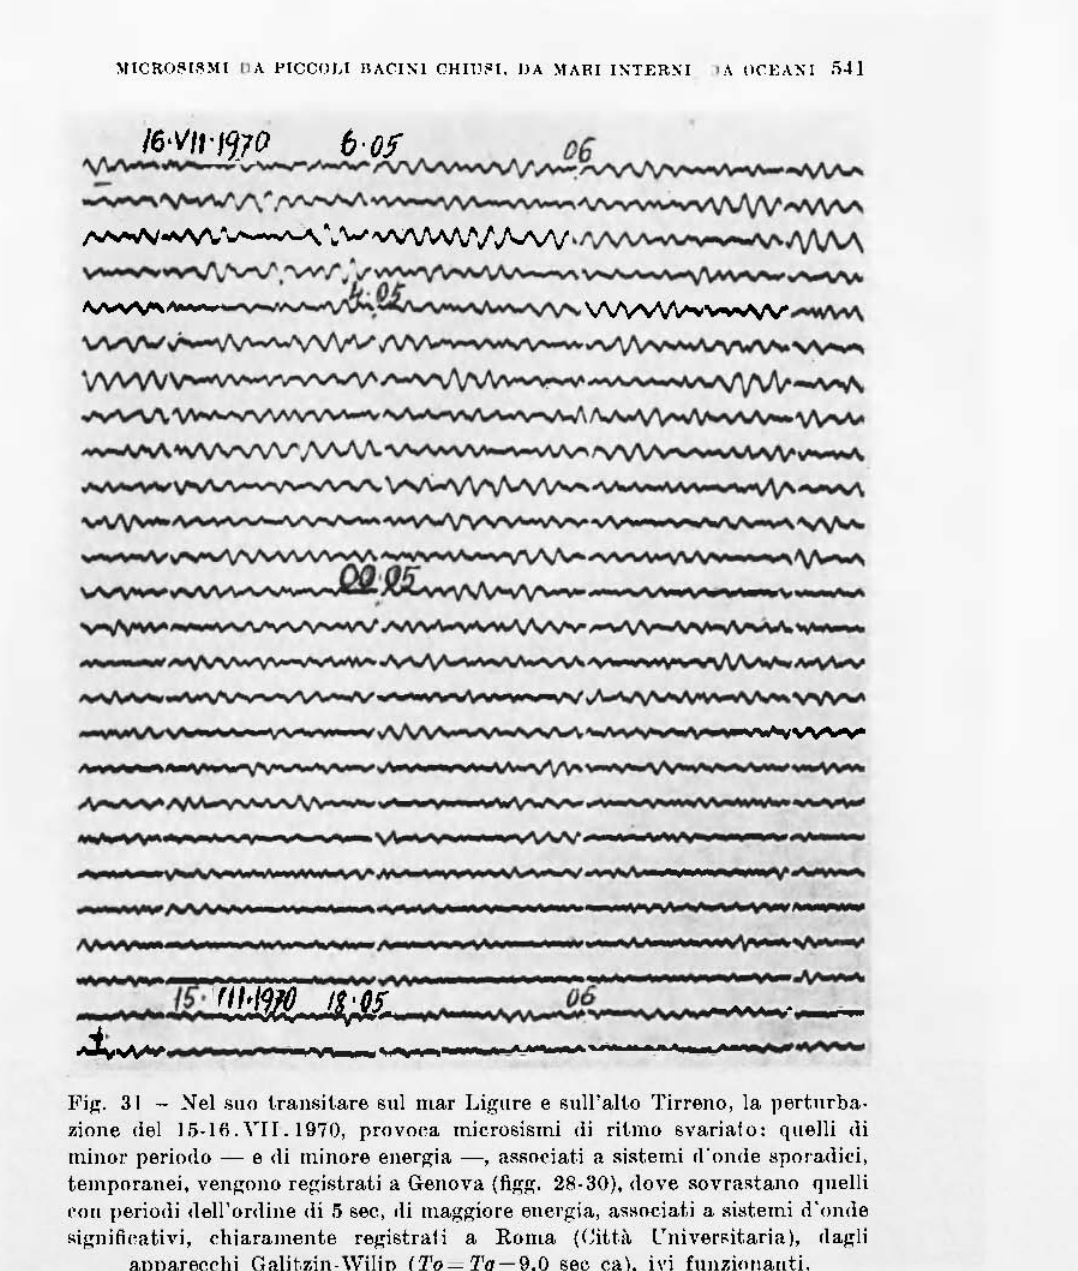
Fig. 31 - )l"el suo transit.are sul mar Ligure e sull'alt.o Tirreno, la